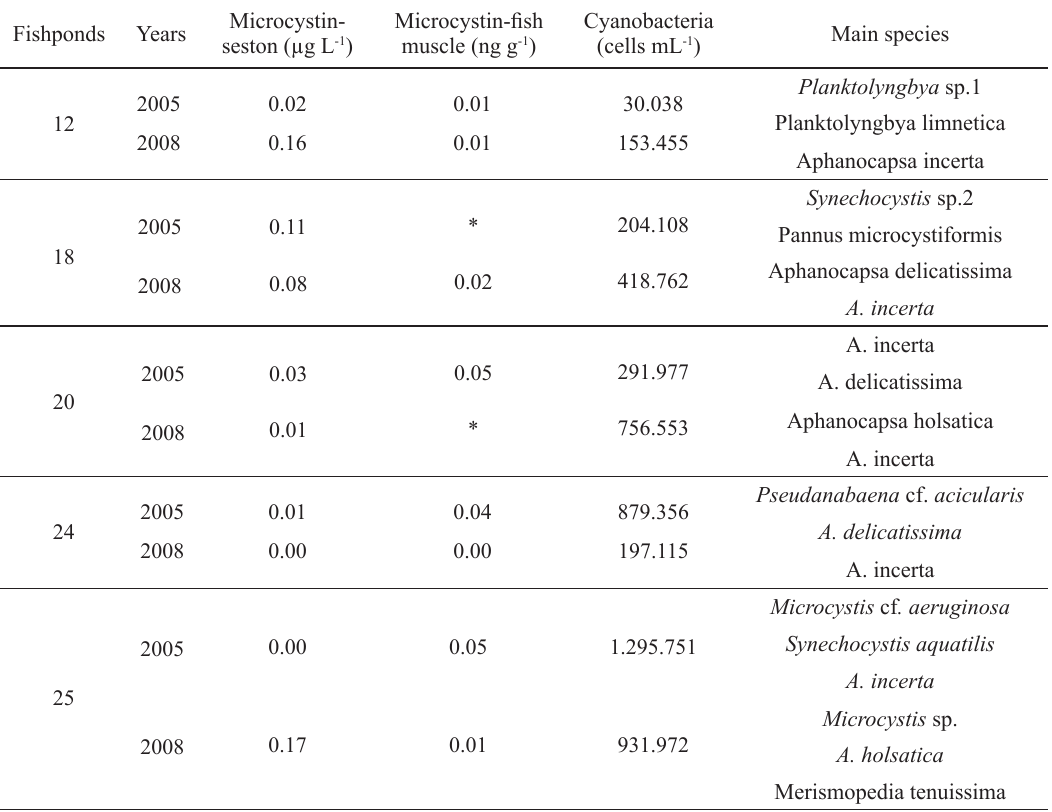
Microcystins in the seston fraction and fish muscle, in five tropical fishponds in southeastern Brazil with high cyanobacterial abundance, in 2005 and 2008. (*Samples not